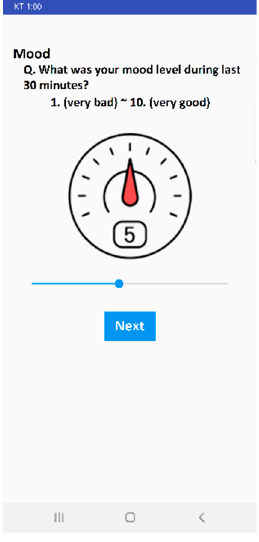
Figure 5. An Ecological Momentary Assessment (EMA) snapshot on mood.